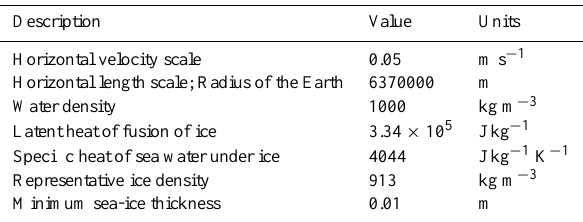
Table A3. : Dimensional scale values, and constants of the sea-ice model component.